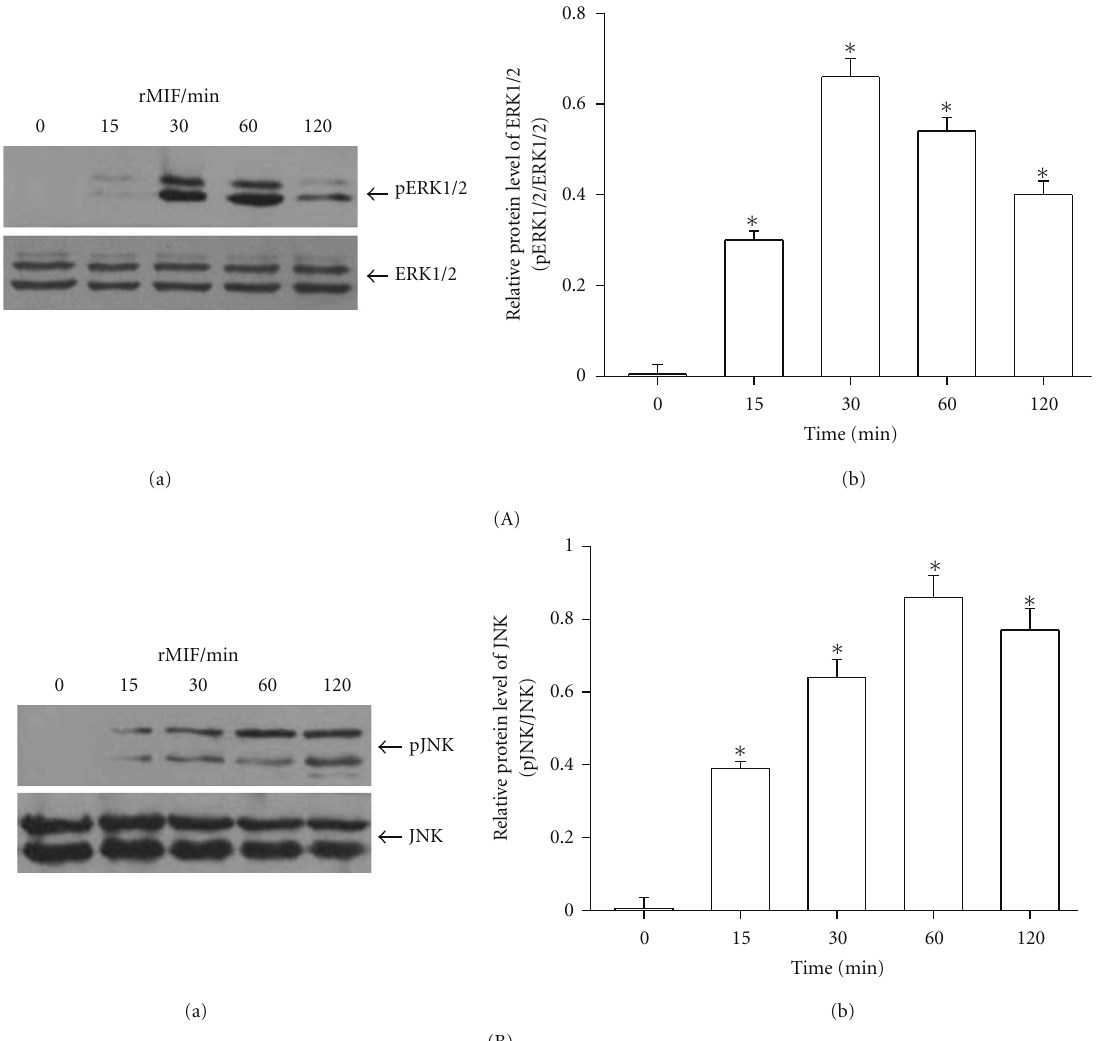
Figure 6: MIF induced ERK1/2 and JNK phosphorylation in rat PASMCs. PASMCs were treated with MIF (100ng/mL) for di ff erent time points. Significant ERK1/2 (A) and JNK (B) phosphorylation was induced after 15min of MIF treatment. (A) Cell lysates were subjected to immunoblotting analysis using antibodies against phospho-ERK1/2 (p ERK1/2) and total ERK1/2 (a). Bar graph showed ERK1/2 protein levels obtained from quantitative densitometry analysis (b). (B) Cell lysates were subjected to immunoblotting analysis using antibodies against phospho-JNK (p JNK) and total JNK (a). Bar graph showed JNK protein levels obtained from quantitative densitometry analysis (b). n = 5. ∗ P < 0 . 05 versus